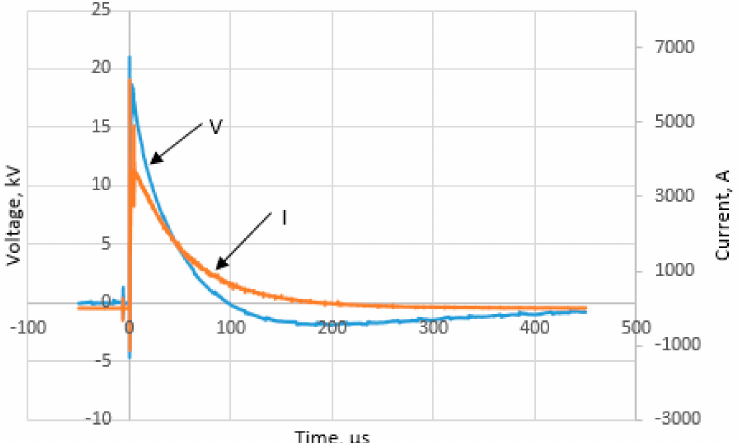
Figure 11. Voltage and current traces of positive polarity for sample A at a charging voltage of 180